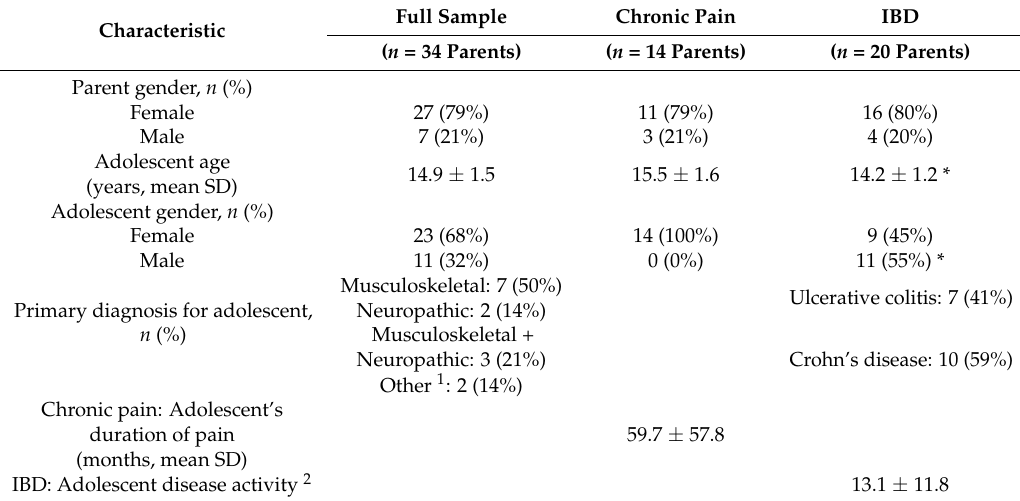
Table 2. Demographic Characteristics ( n = 34